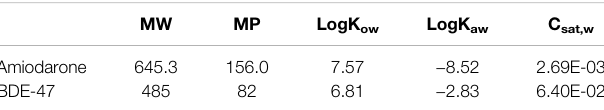
TABLE 1 | Properties of case chemicals used in repeat dose scenarios. Data retrieved from Pubchem https://pubchem.ncbi.nlm.nih.gov/ and the UFZ LSER database